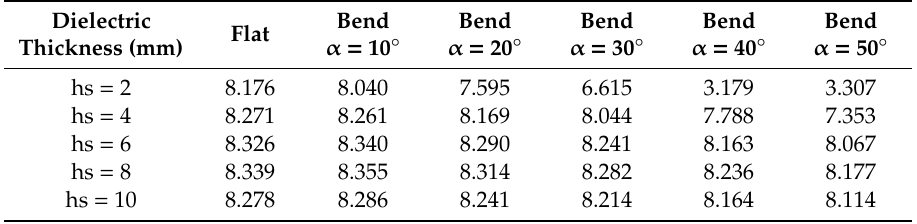
Table 2. Simulated antenna radiation pattern gain (dBi) for flat and bend positions at 2.45 GHz.